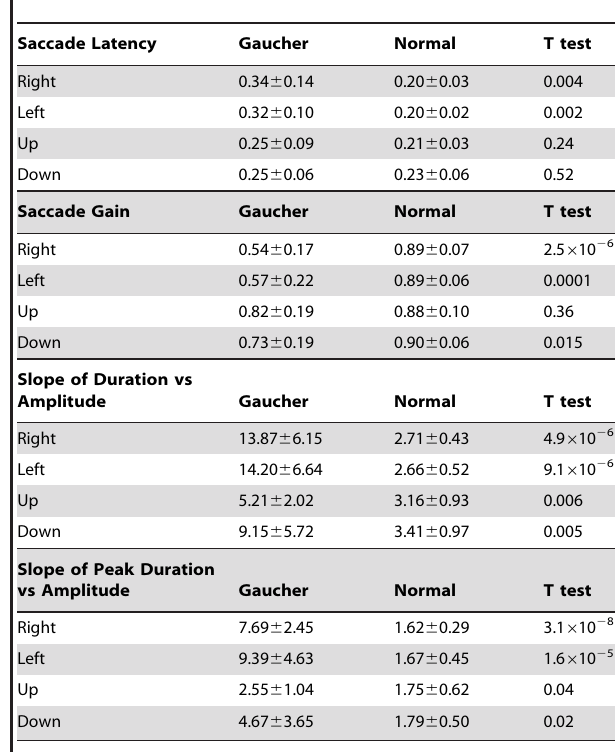
Table 1. Saccade Characteristics. Comparison of saccade parameters of patients and normal controls using data from their last